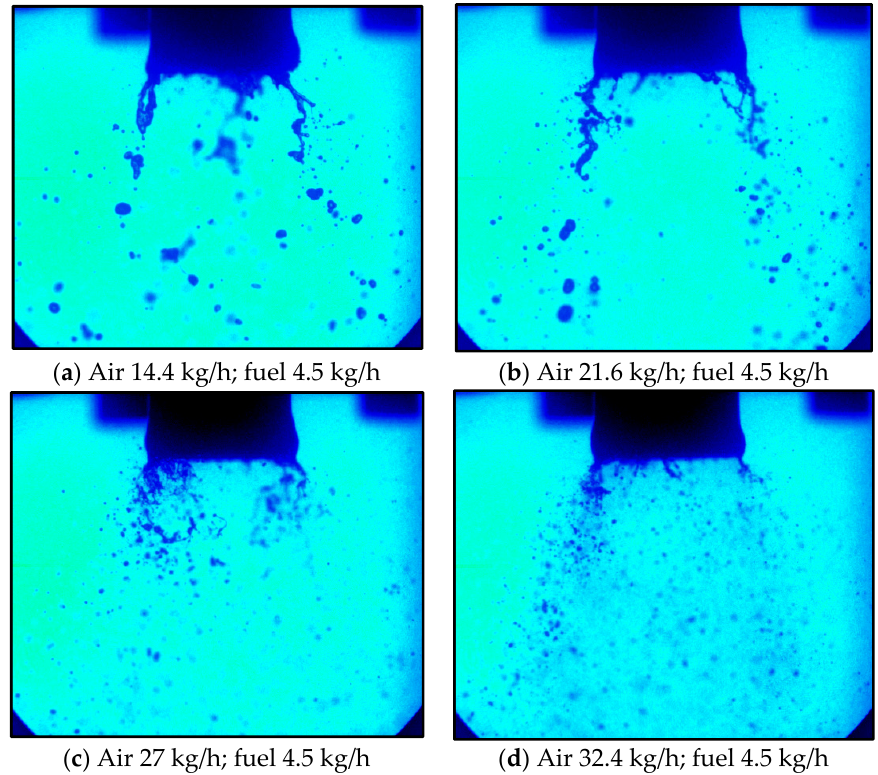
Figure 16. The influence of air mass rate on liquid film breakup process (Case B) (Transient results).